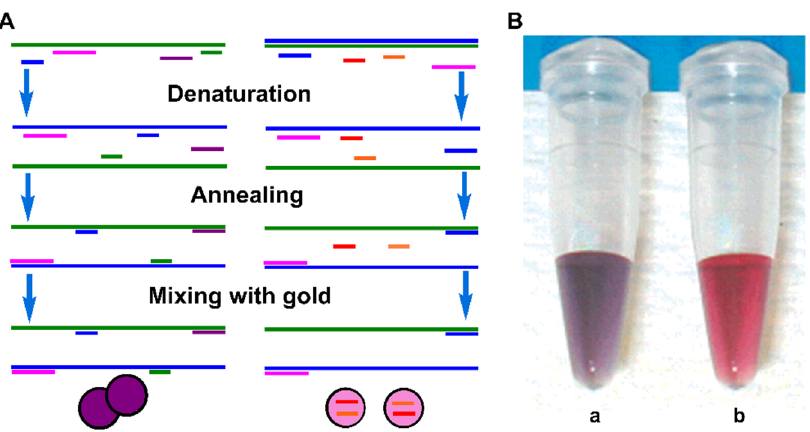
Figure 1. ( A ) Schematic diagram of detection of PCR product with AuNPs; ( B ) color images of the solutions with complementary ssDNA probes ( a ) and noncomplementary ssDNA probes ( b ). Adapted with permission from ref [46]. Copyright 2004 American Chemical Society.